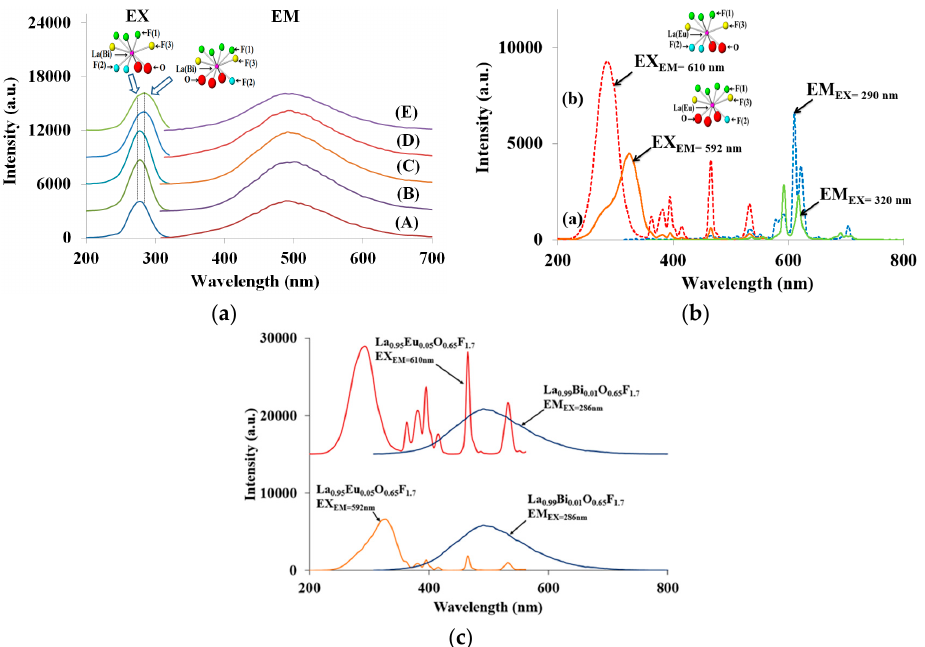
Figure 3. PL excitation and emission spectra of ( a ) La 1- p Bi p O 0.65 F 1.7 phosphors (A) p = 0.001, (B) 0.005, (C) 0.01, (D) 0.025, and (E) 0.05; and ( b ) La 0.95 Eu 0.05 O 0.65 F 1.7 phosphors; and ( c ) the excitation spectra of